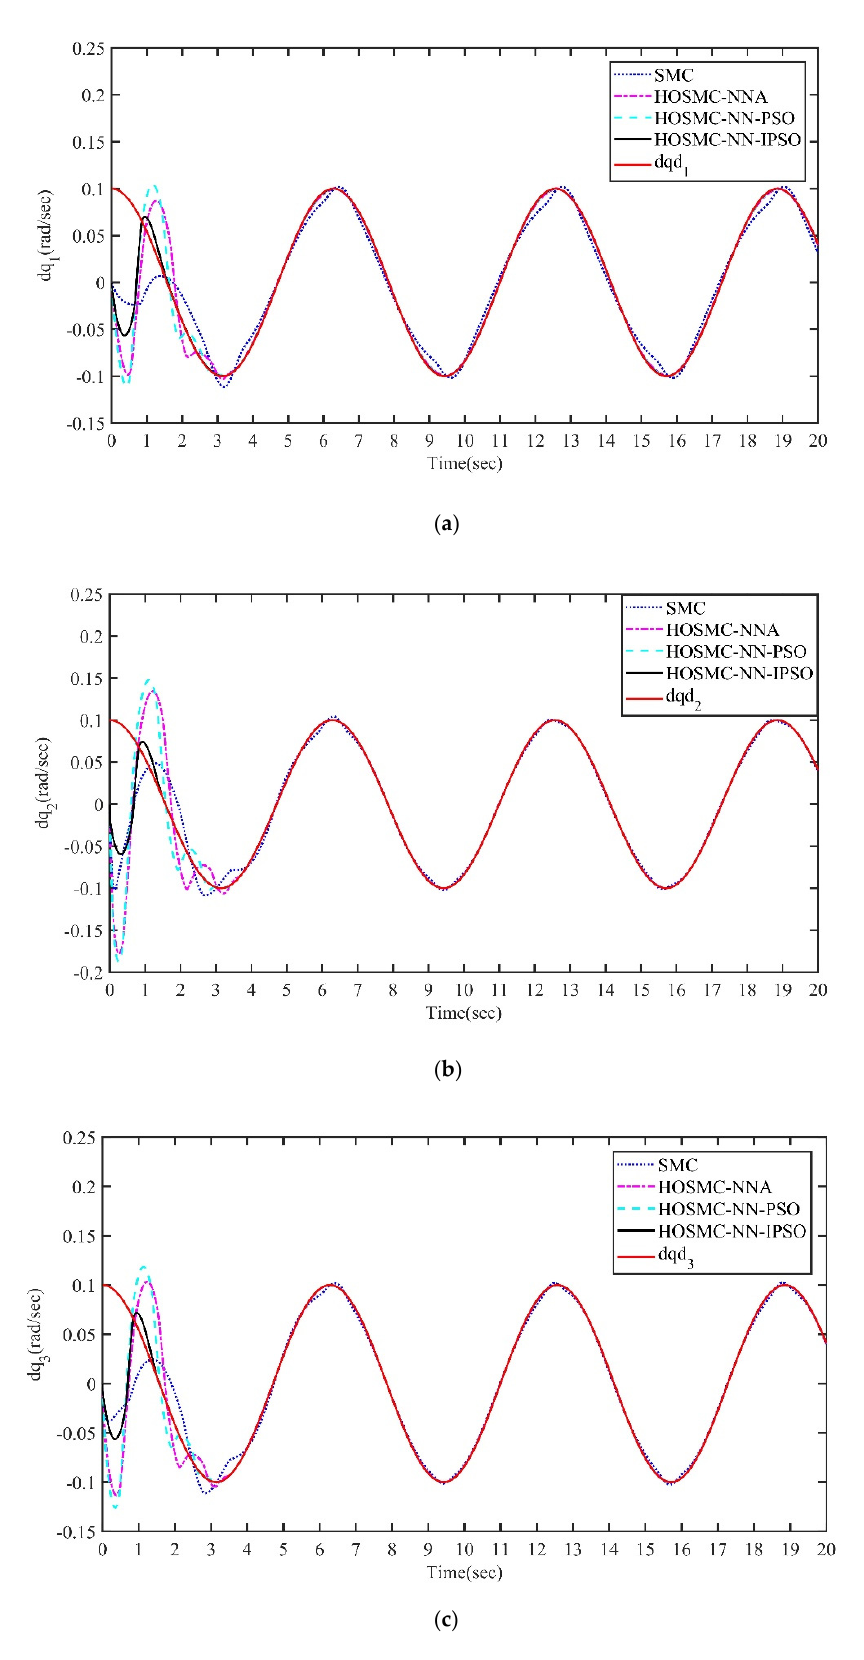
Figure 6. Angular velocity tracking of joints under SMC, HOSMC − NNA, HOSMC − NN − PSO and HOSMC − NN − IPSO controllers. ( a ) Angular velocity tracking of joint 1. ( b ) Angular velocity tracking of joint 2. ( c ) Angular velocity tracking of joint